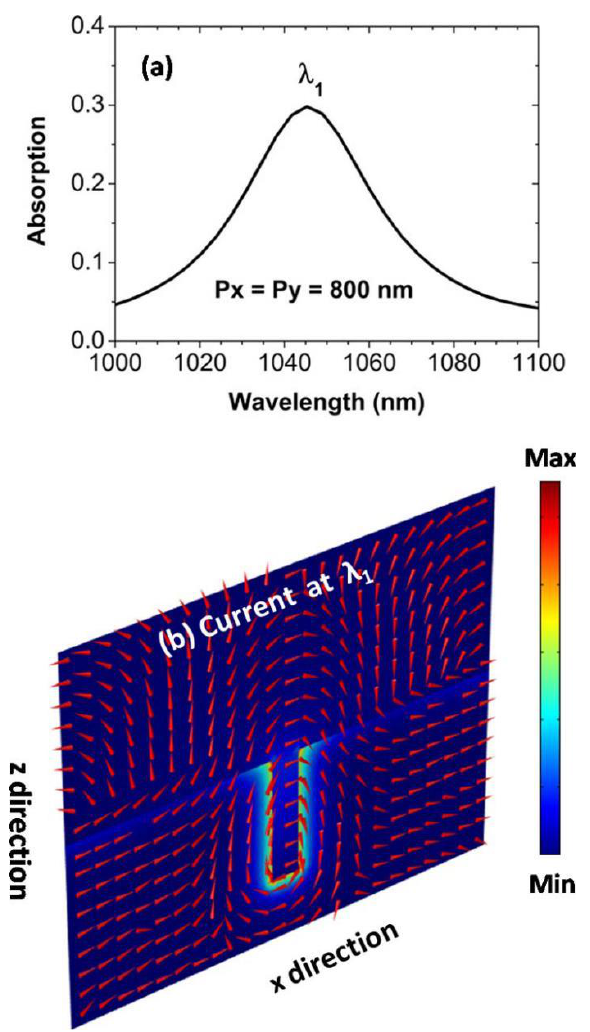
Figure 2. ( a ) Numerically calculated absorption spectra at normal incidence, with geometrical parameters of p x = p y = 800 nm, L = 500 nm, d = 200 nm, and w = 50 nm. ( b ) Current distributions at the wavelength of λ 1 on the xz plane along the white dotted line in Figure 3a. The colors represent the current strength, and the red arrows give the current directions.